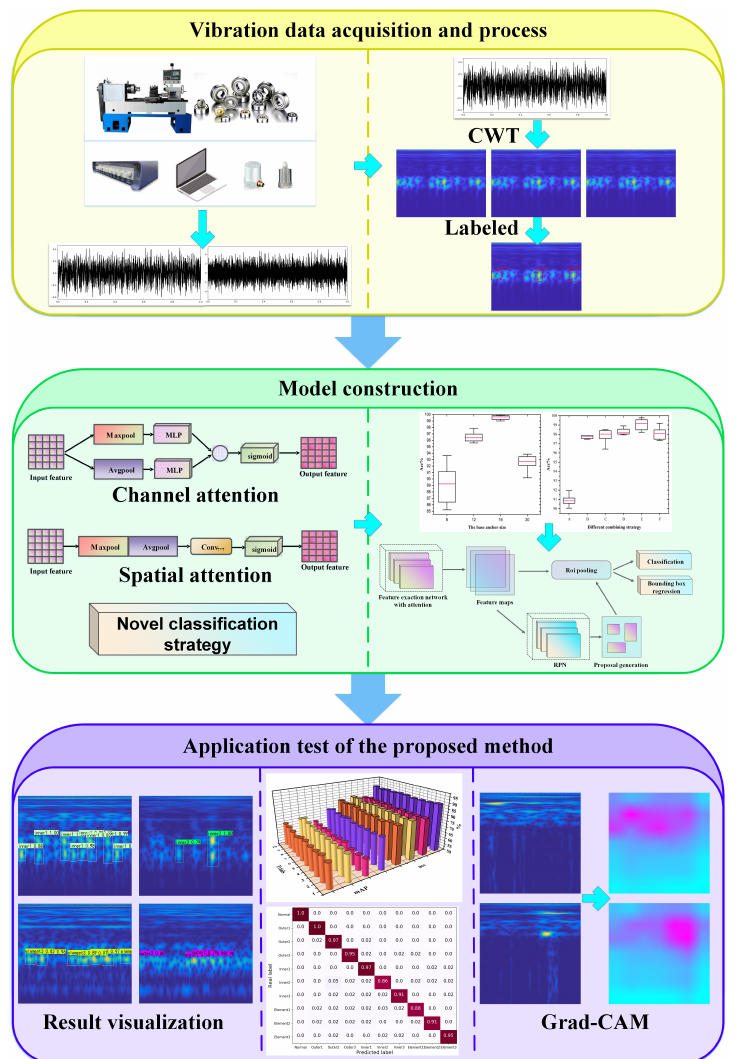
Figure 7. The framework of the proposed